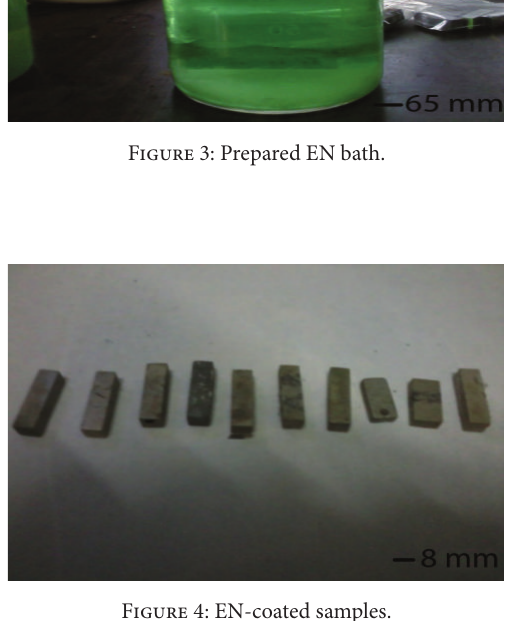
Figure 4: EN-coated samples.